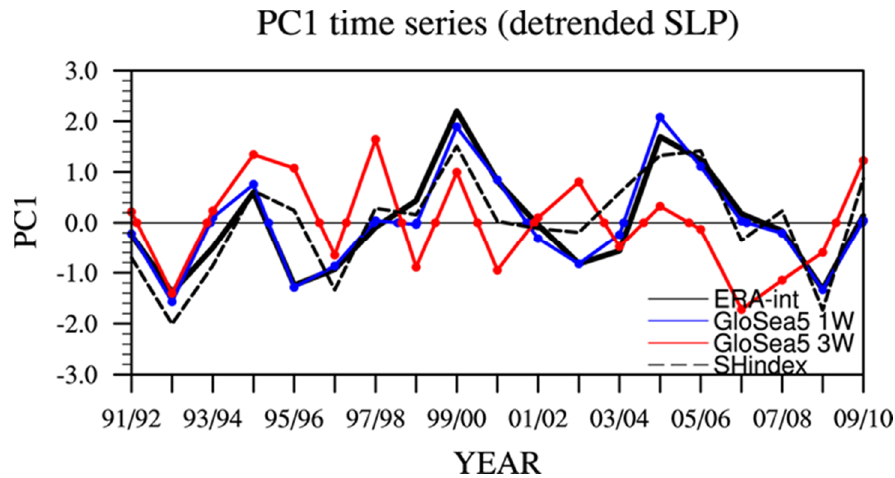
Figure 9. Leading mode governing detrended winter sea level pressure from ERA-Interim ( black solid line ), and GloSea5 with lead times of 1 week ( blue line ) and 3 weeks ( red line ). The black dashed line indicates the Siberian high index.